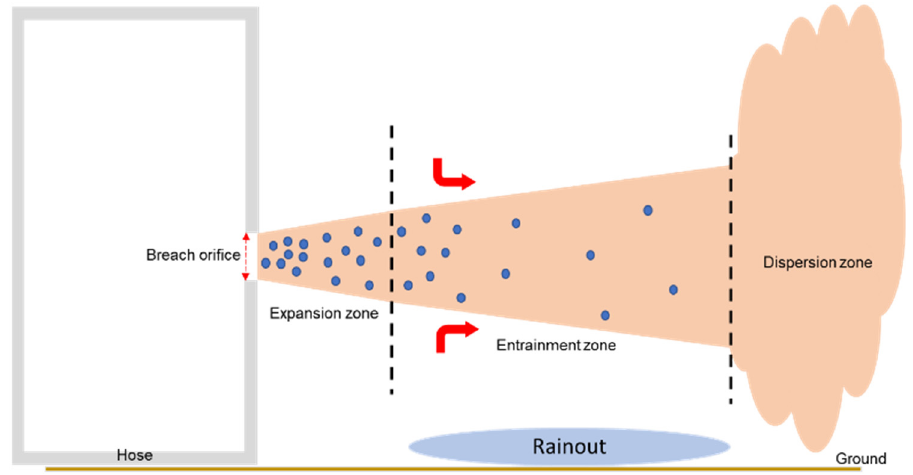
Figure 1. Schematic representation of the zones in jet leak.